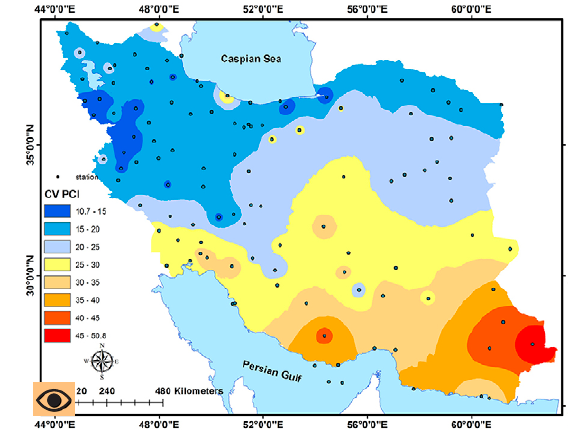
Figure 4. Spatial distributions of PCI across Iran over the period 1988-2017